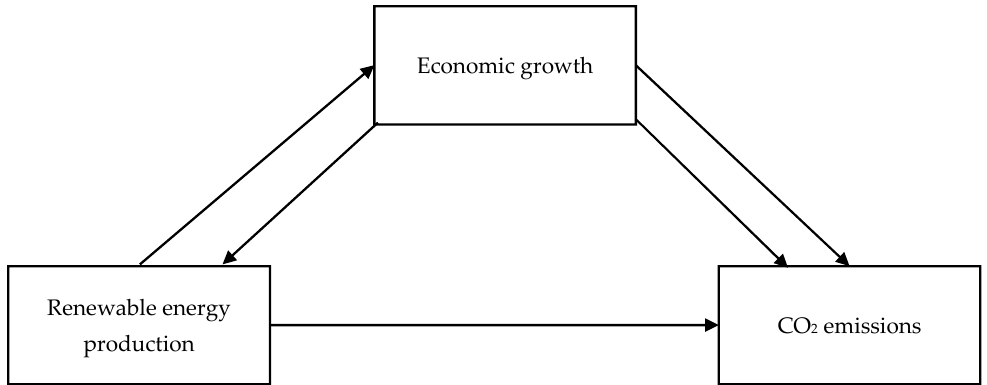
Figure 2. The long-run relationship between renewable energy production, CO 2 , and economic growth for ASEAN countries.